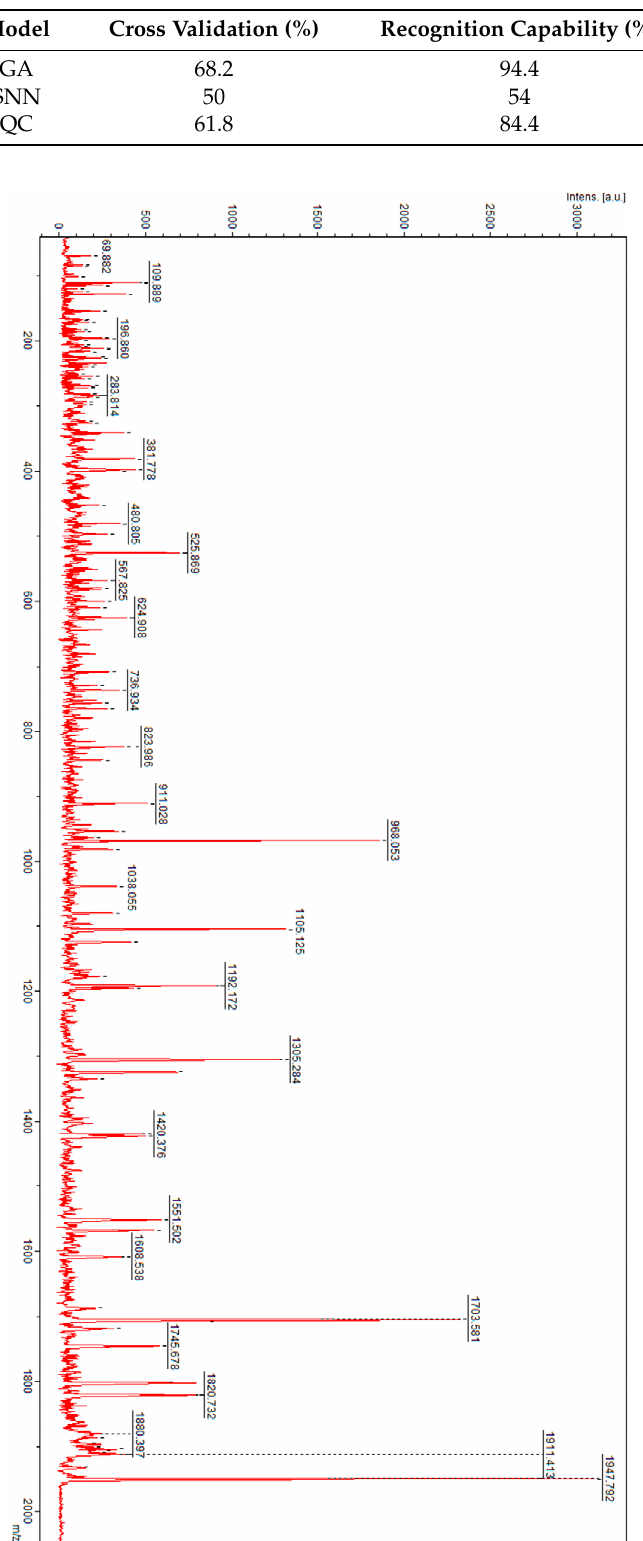
Figure 3. Fragmentation spectrum of precursor ion of m / z 1951.81 identified as hemoglobin subunit α .